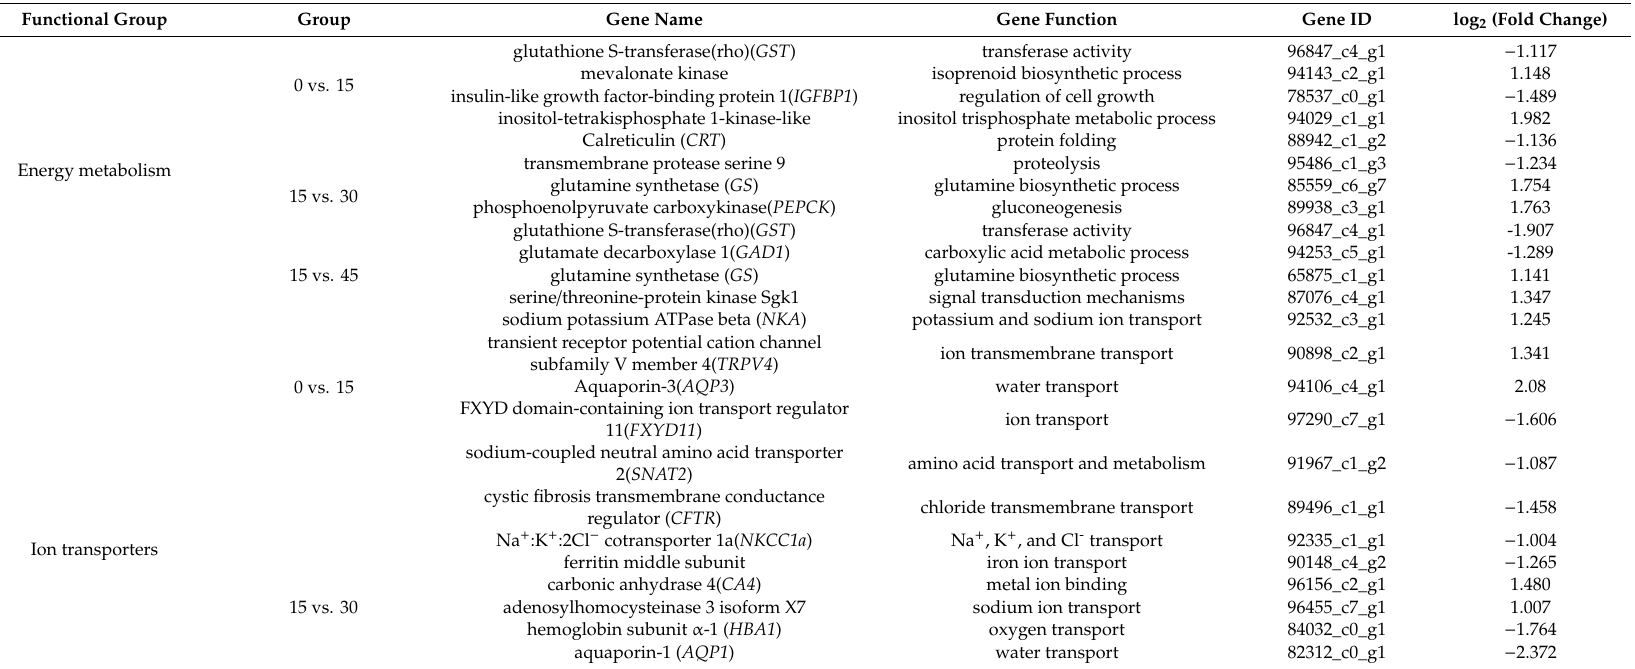
Table 2. Representative osmotic pressure related genes involved in salinity